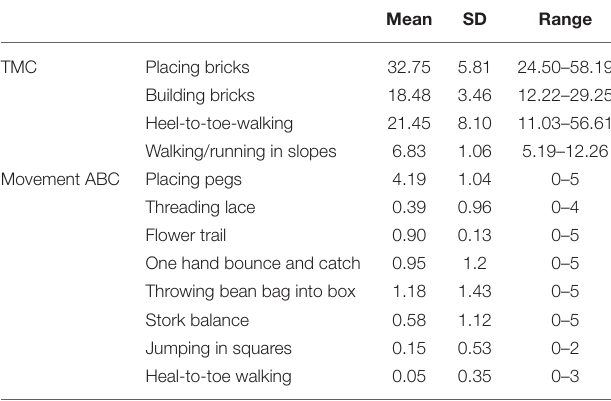
TABLE 1 | The mean and standard deviation (SD) for measures of tasks in TMC and MABC.